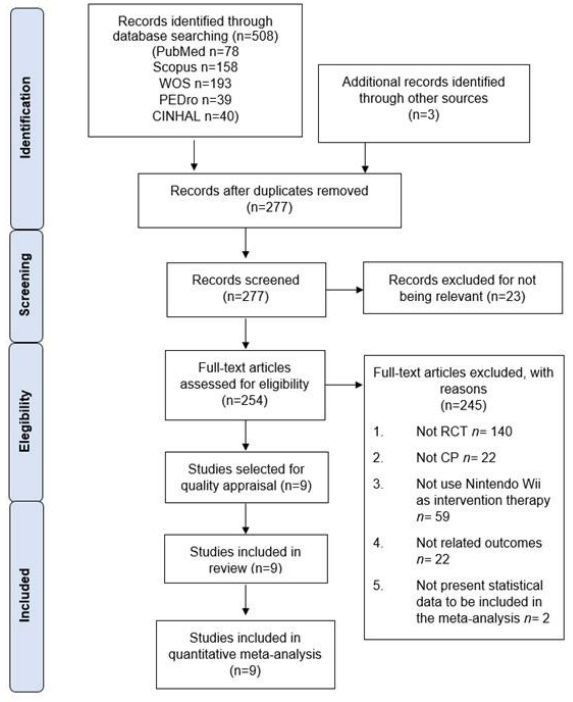
Figure 1 . PRISMA flow chart of the study selection process . Figure 1. PRISMA flow chart of the study selection